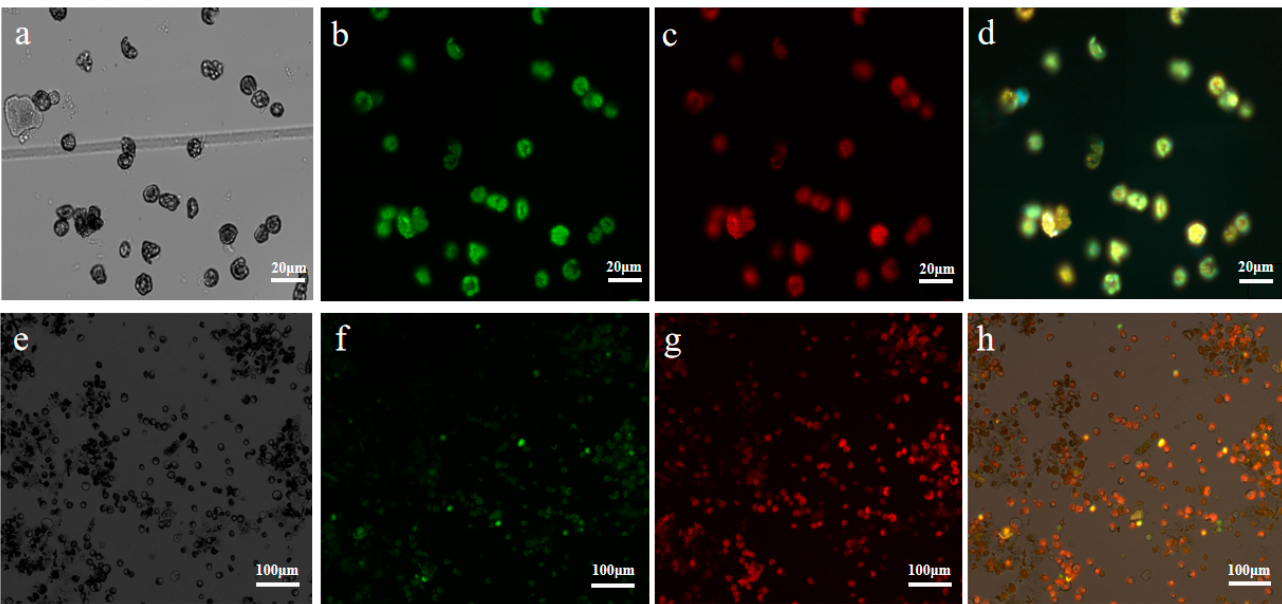
Figure 4. Transient UrWRKY37 gene expression in U. rhynchophylla protoplasts observed under a